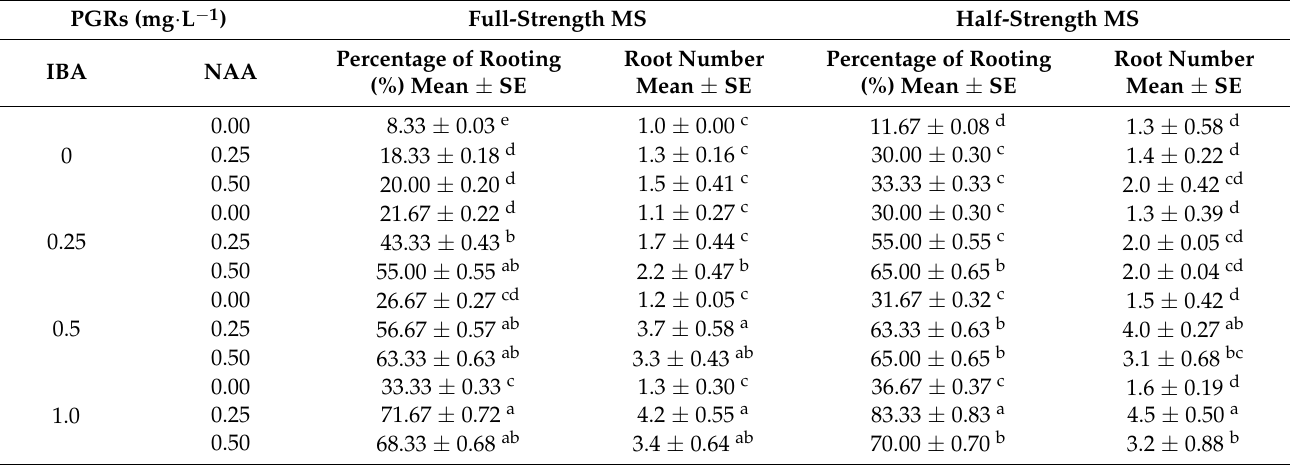
Table 3. Effects of different IBA and NAA combinations on root induction of A. crenata